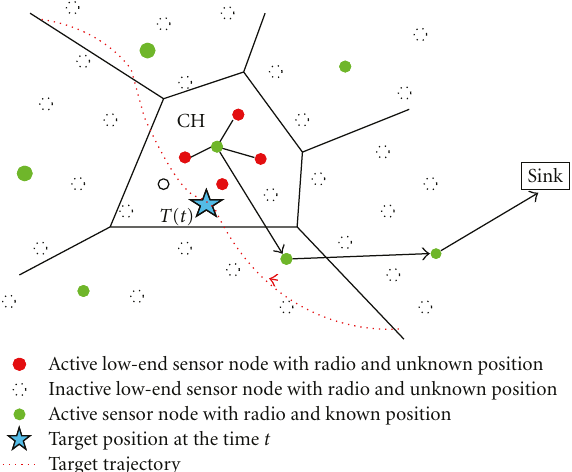
Figure 1: Sensor network